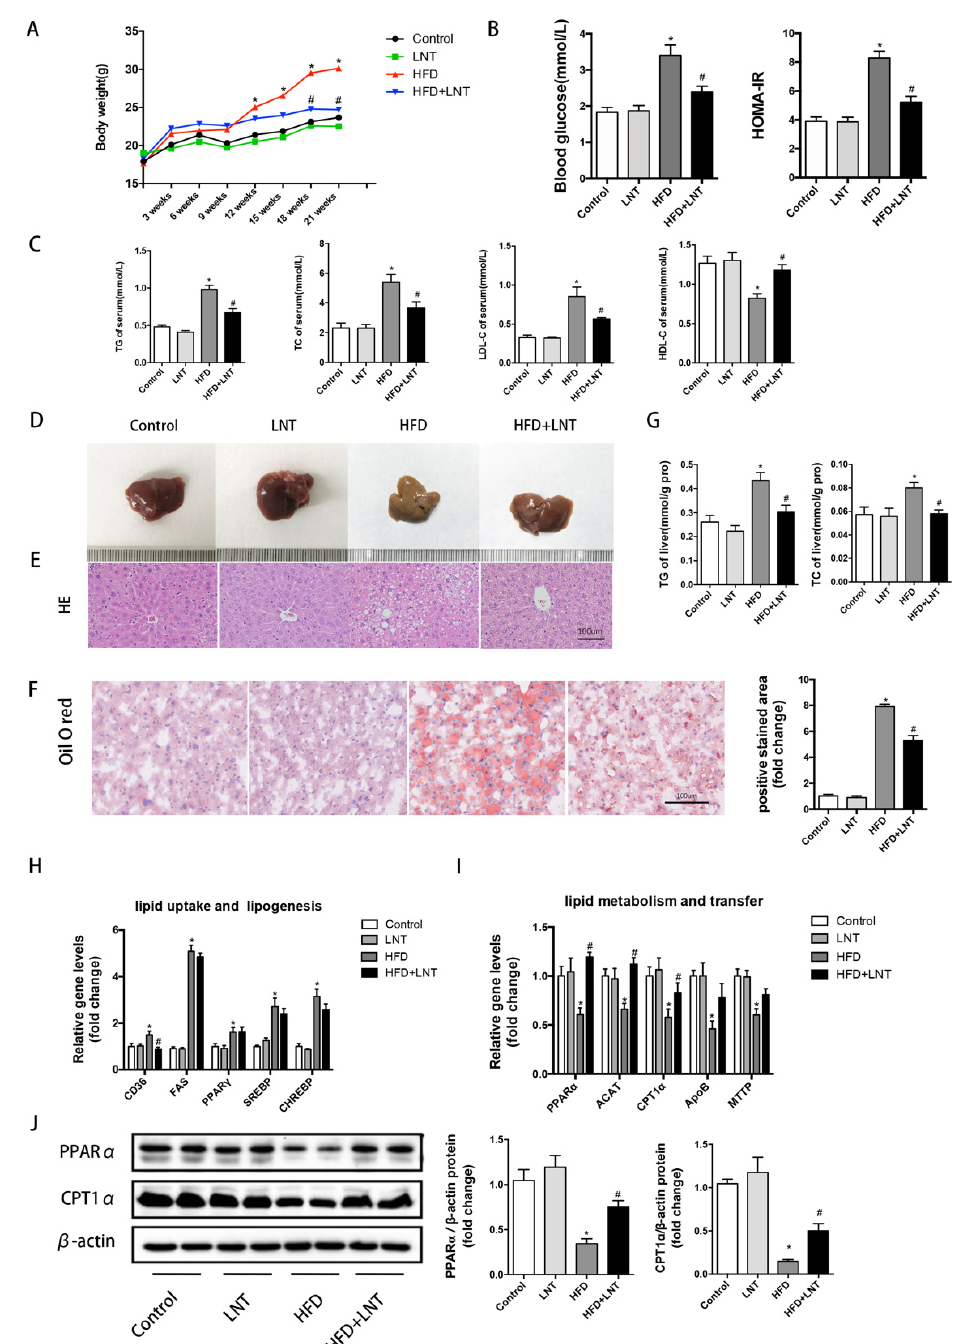
Figure 1. LNT ameliorated HFD-induced steatosis in mice. ( A ) Body weight, ( B ) blood glucose and HOMA-IR in four groups of mice. ( C ) Serum levels of TG, TC, LDL-C and HDL-C were determined. ( D – F ) Representative images of H&E and oil red O staining of the liver in mice. ( G ) Liver TG and TC content. ( H , I ) Hepatic mRNA levels of lipid uptake-, lipogenesis-, metabolism-, and transfer-related genes. ( J ) Representative Western blots and quantification of PPAR α and CPT1 α in the liver. Data are presented as means ± SEM ( n =8 per group). * p < 0.05 compared with the Control group. # p < 0.05 compared with the HFD group.